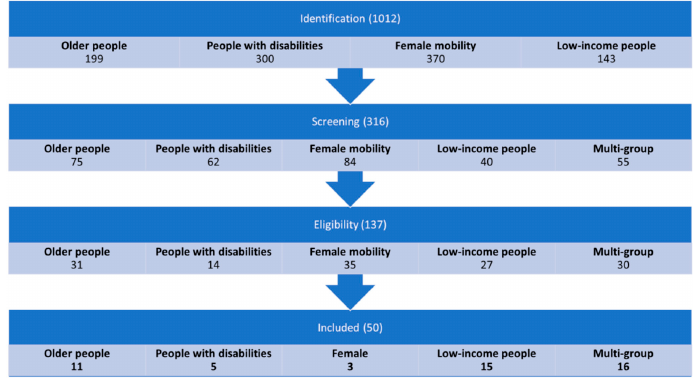
Figure 1. The four stages of the PRISMA protocol and the number of papers identified per stage.